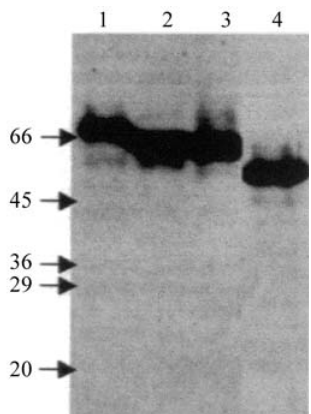
Figure 4 - Electrophoretic separation of G2/G4 fusions synthesized in vi- tro. Lane 1: G4 synthesized protein using plasmid pSP65/248 ; Lane 2&3: G2HG4 synthesized protein using plasmid pSP65/G2HG4 ; Lane 4: G4HG2 synthesized protein using plasmid pSP65/G4HG2 . Protein stan- dards are